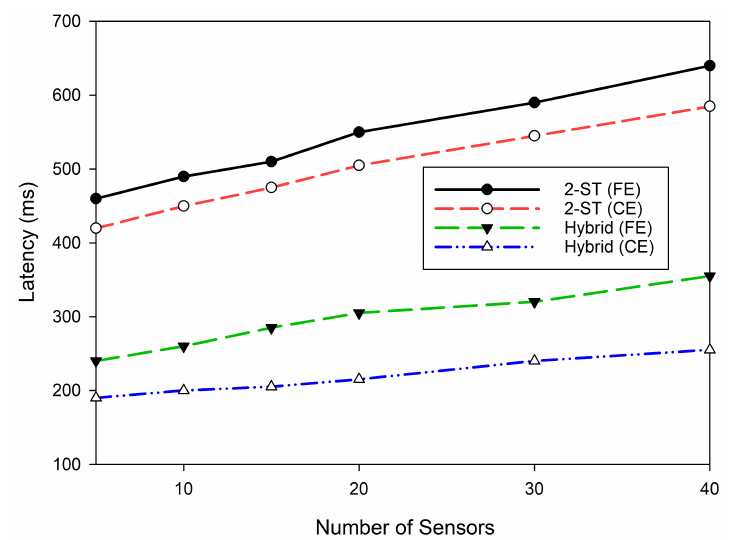
Figure 6. Latency comparison of the 2-ST and hybrid approaches for both the cloud and fog